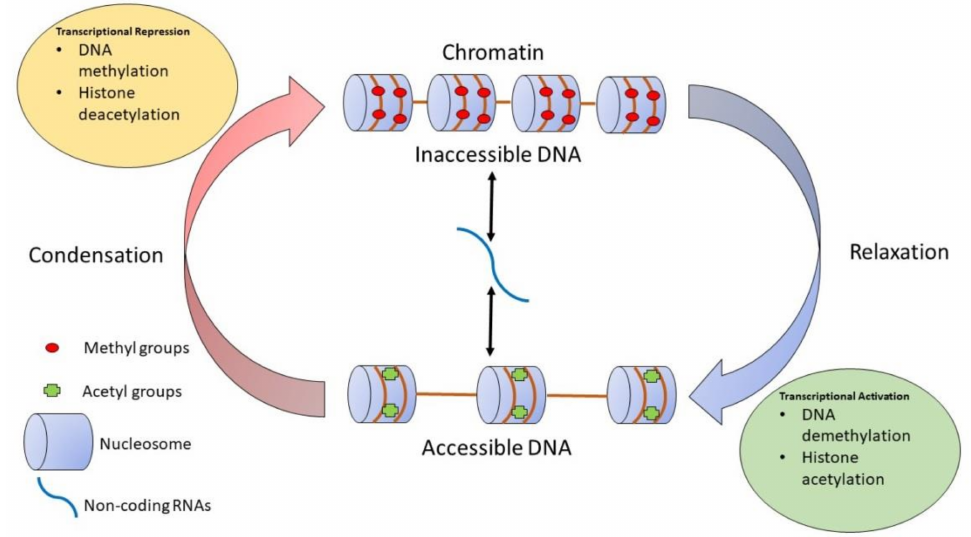
Figure 1. The diagram shows how gene expression is subject to epigenetic regulation. Epigenetic alterations can occur as DNA methylation and/or histone modifications and modify the accessibility of genes to the transcriptional machinery. This takes place either by inducing a relaxed/open or condensed/closed chromatin state. In addition, non-coding RNAs such as miRNAs can regulate the cell phenotype by repressing or enhancing the expression of gene transcripts. These non-coding RNAs can themselves be epigenetically regulated. Reprinted from